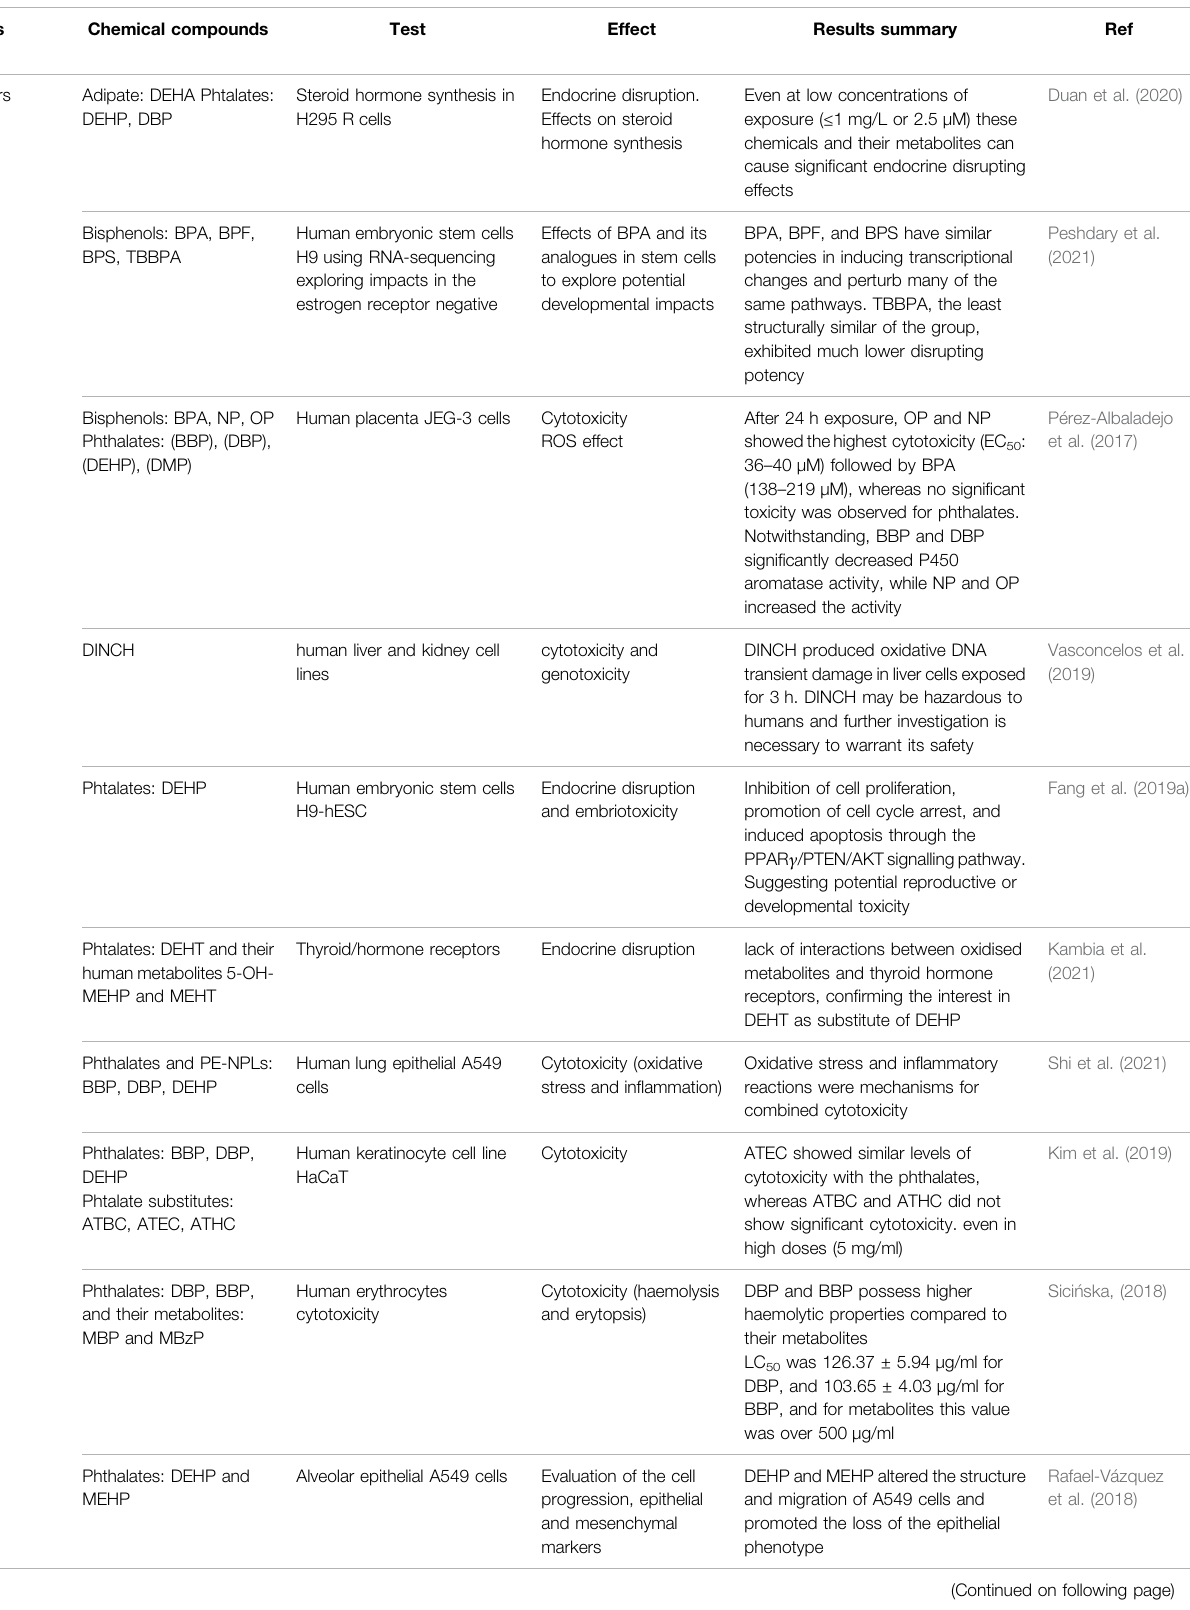
TABLE 4 | Examples toxicological assays of plastic additives using human